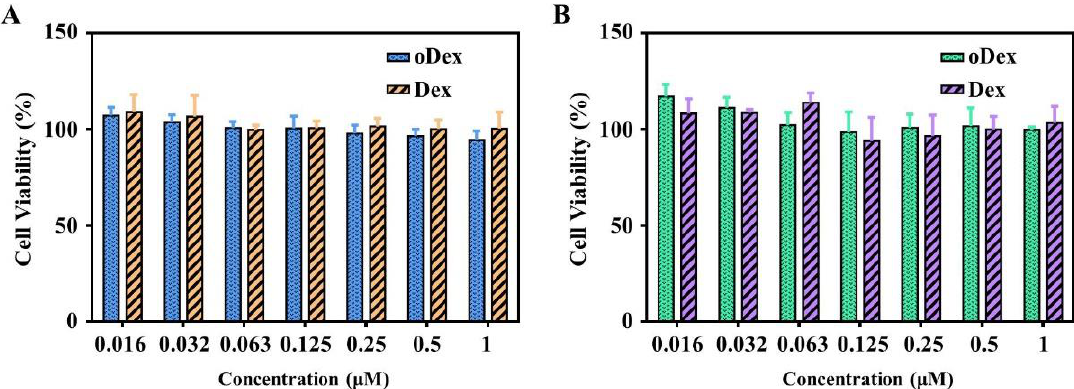
Figure 5. Cytotoxicity assay. Cell viability of L929 ( A ) and HeLa ( B ) cells after 48 h incubation with Dex (dextran) or oDex (oxidized dextran) at different concentrations.